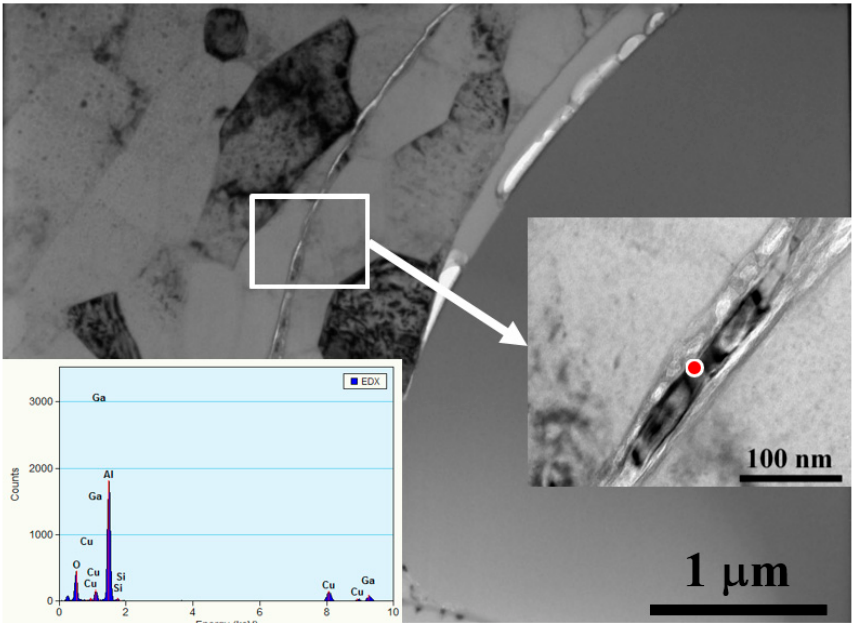
Figure 7. TEM images for the inserted ~15 μ m SiO 2 particle in the 1050 Al plate, with the EDS spectrum on the bottom left. Occasionally, there would be some gaps between the inserted SiO 2 and Al matrix. Note that sometimes there is an external thin Al 2 O 3 oxide layer (shown on the enlarged image on the right) inserted into the Al inner position with the mechanical coated large particles.